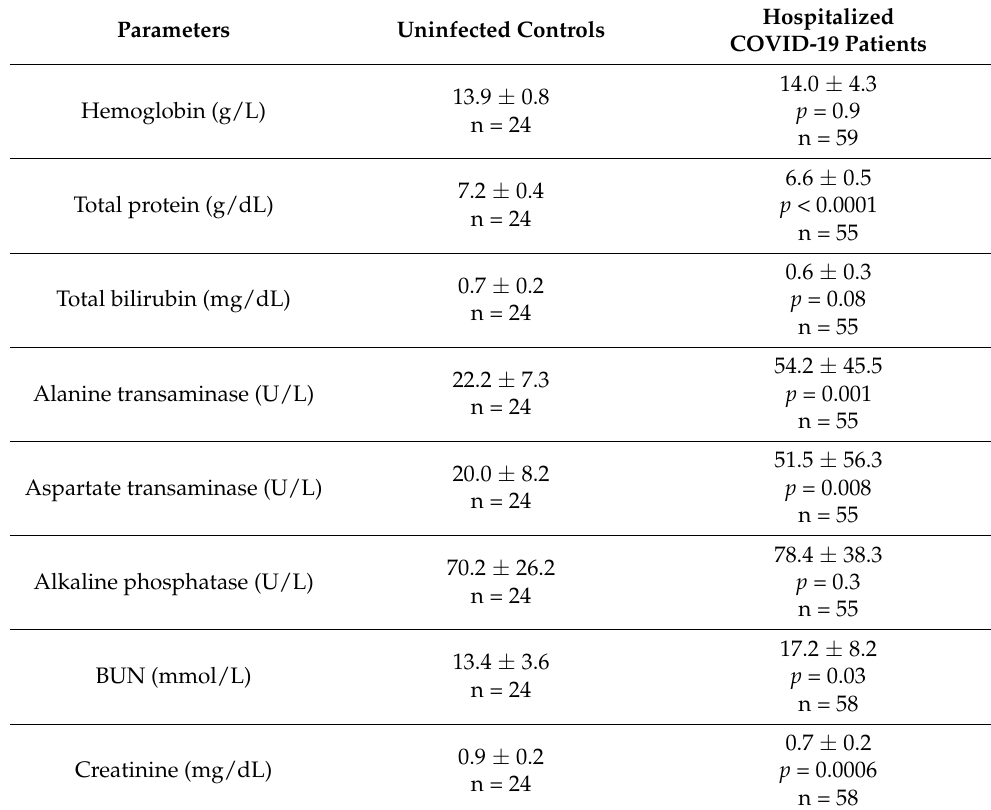
Table 1. Plasma biochemistry. Values are means ± SD. Means are significantly different at p < 0.05.